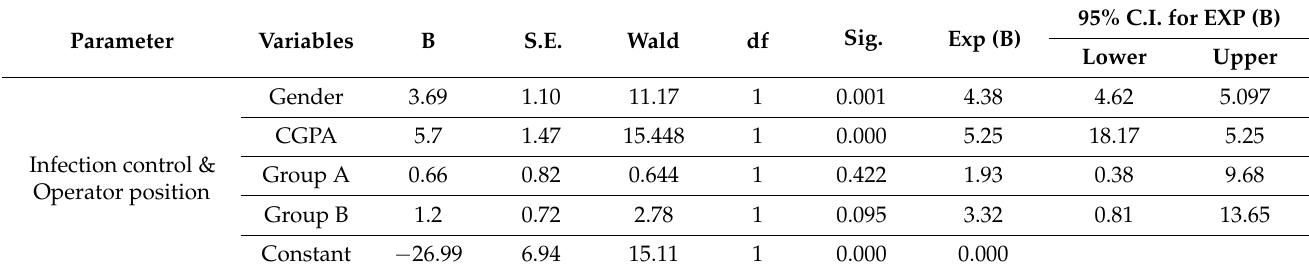
Table 3. Expressing the effect of infection control and operator position parameters on gender, CGPA, Group A and Group B using binary logistic regression analysis.